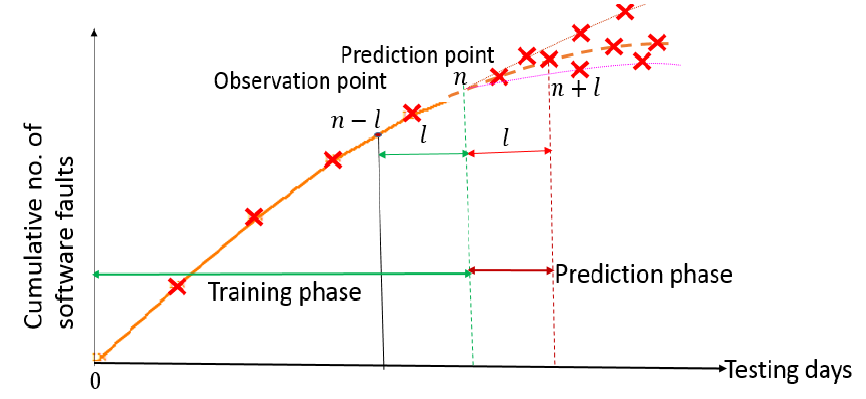
Fig. 2. Configuration of prediction scheme via